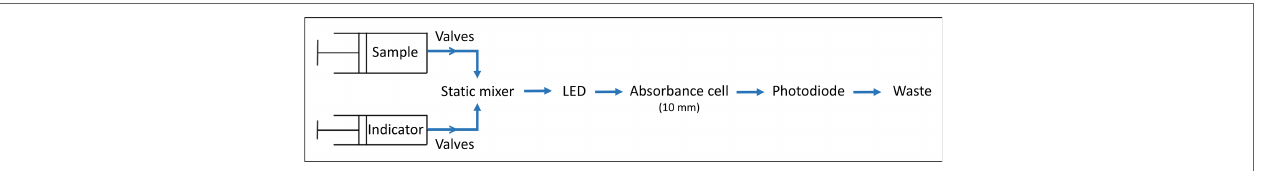
FIGURE 1 | The schematic diagram of the fluidic design of the LOC pH